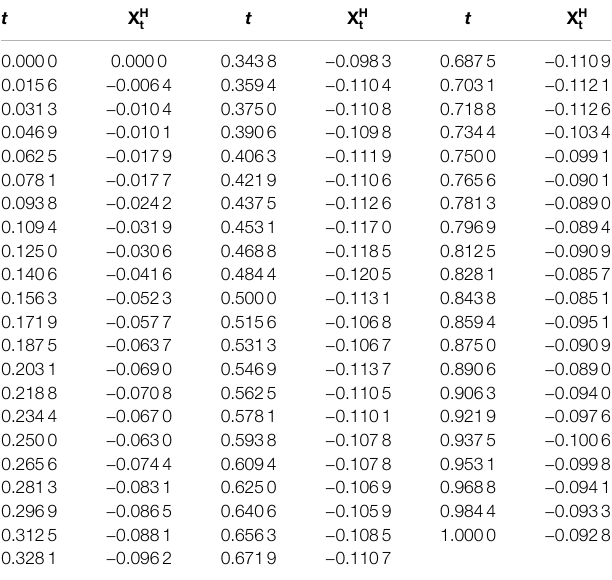
TABLE 2 | Data of X H t with θ (cid:1) 10 and H (cid:1) 0.7